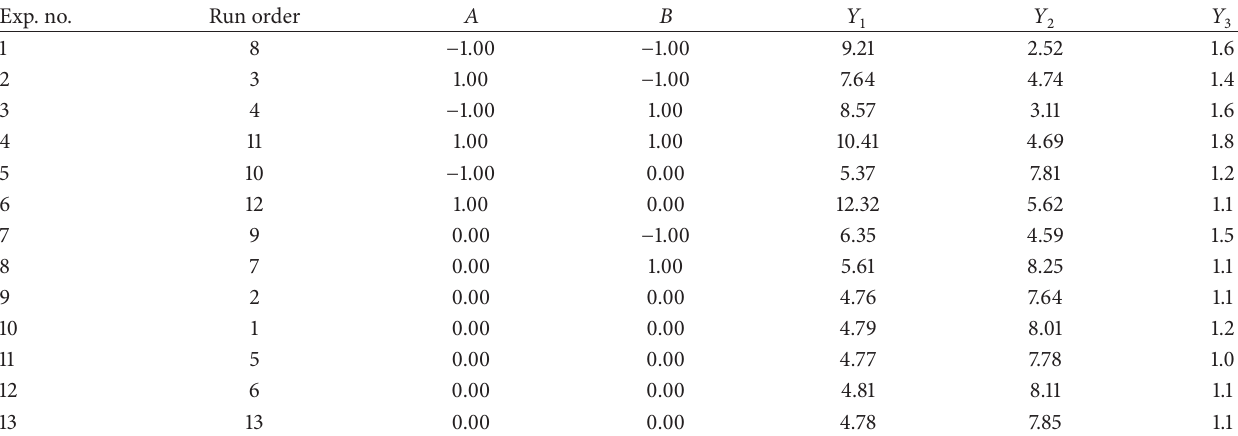
Table 2: Experimental conditions according to the central composite design and observed response values. Exp.